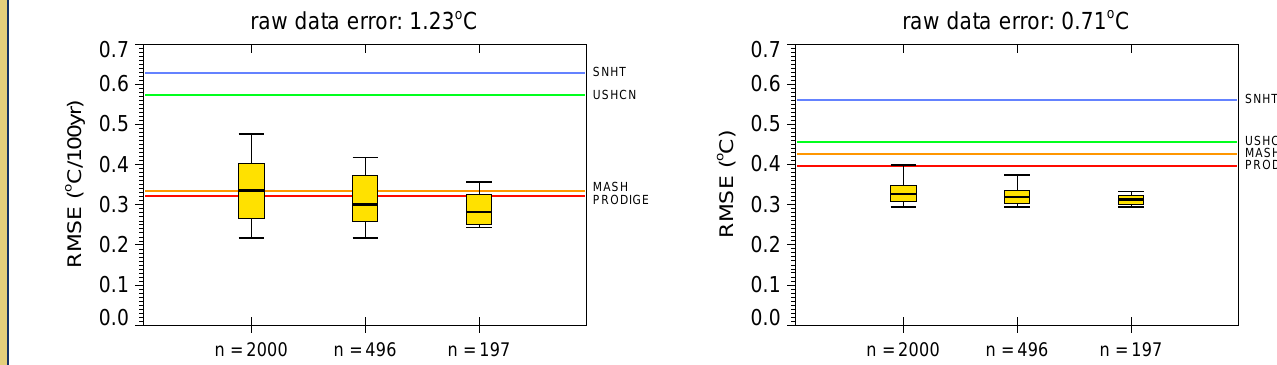
Figure 2. Boxplot of the residual errors in trend biases of station series after homogenising with ACMANT the HOME surrogated temperature data. Left column is for all the 2000 experiments, while for the middle and right columns some suboptimal parameters are excluded. Boxes include the values between 5 and 95 percentiles. Raw data errors and residual errors after blind homogenisation with various methods under HOME are also shown.